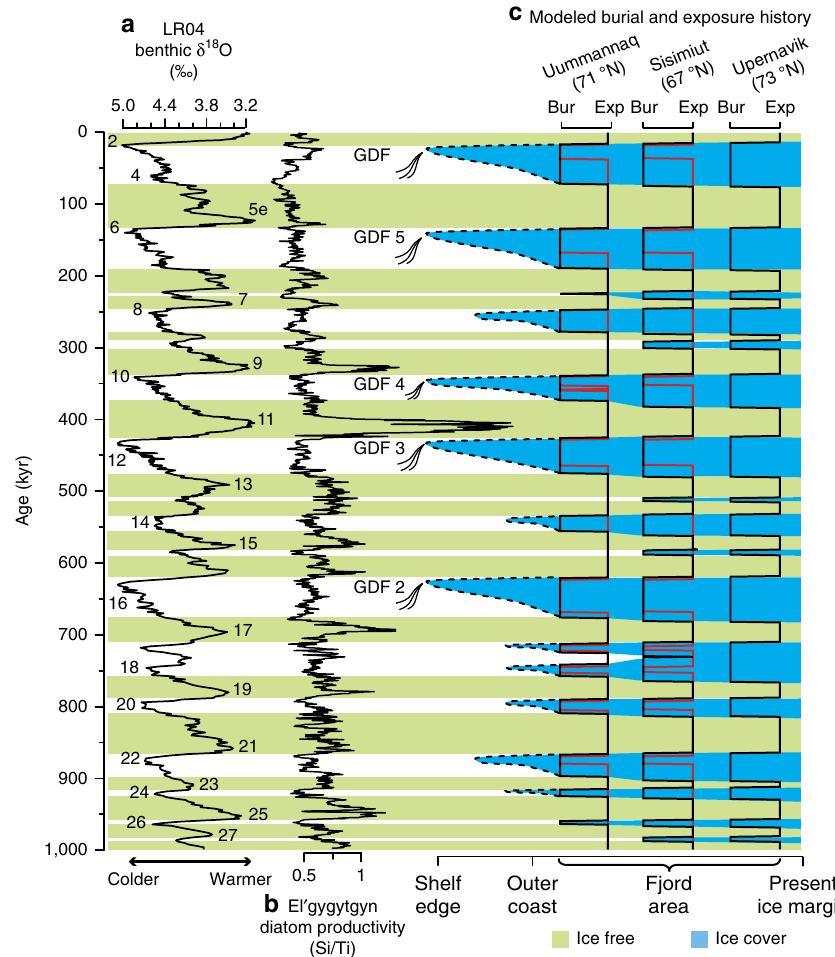
Figure 4 | Climate and modeled glaciation history in west Greenland throughout the last 1Myr. ( a ) The stacked benthic marine d 18 O record 23 is a proxy for global ice volume and is divided into numbered marine isotope stages (MIS). We determine the exposure history by applying a threshold to this global climate record. ( b ) The diatom productivity curve from Lake El’gygytgyn 35 , which is a temperature proxy based on limnic Arctic data, indicating very warm conditions during MIS 11. ( c ) Quantification of the most likely periods of exposure (‘Exp’ and green coloration) and burial by ice cover (‘Bur’ and blue coloration) based on 39 bedrock samples (black lines) from four sites in the Fjord Area of west Greenland 19,20,24–26 (the Sisimiut exposure/burial history covers the sample sites Itilleq and Sukkertoppen). Red lines mark the glaciation history of samples that only have experienced very short durations of burial and therefore have 26 Al/ 10 Be ratios at or above the production ratio of 6.75. The red lines are based on three samples from Sisimiut and seven samples from Uummannaq. It is likely that the ice sheet extended to the shelf edge and deposited glacial debris flows during the five most prolonged ice-covered periods 5,37